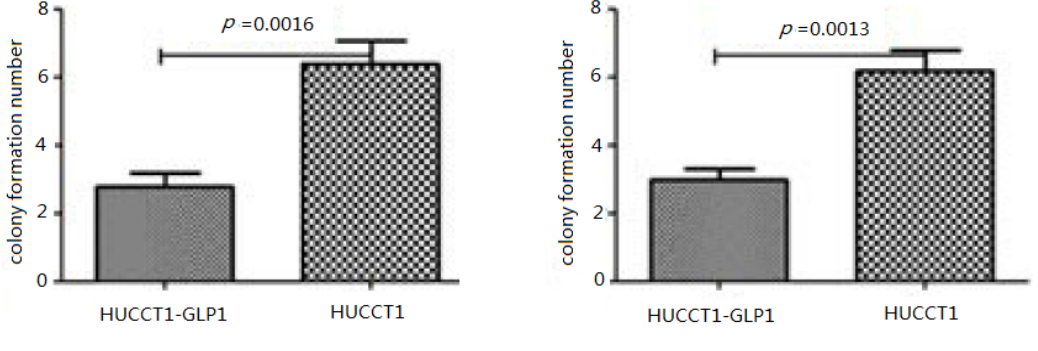
Figure 3. Tumor colony formation after Glucagon-like peptide-1 (GLP-1) and Exendin-4 treatment.